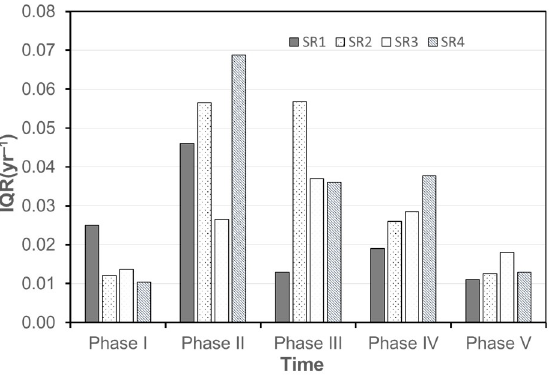
Figure 5. Temporal and spatial variations in interquartile range of the vertical adjustment rate.